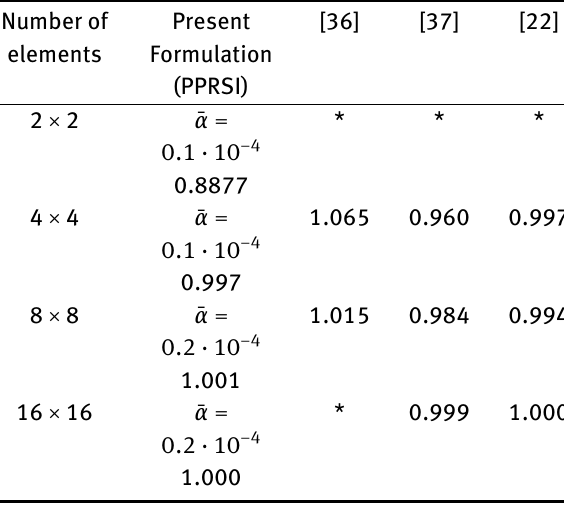
Figure 4: Numerical test example 2 (Scordelis-Lo roof): shell roof in industrial building loaded by a permanent load, due mainly to its